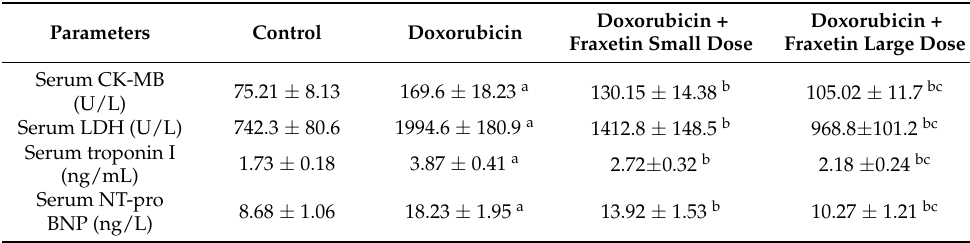
Table 1. Effect of different doses of fraxetin on cardiac function tests in doxorubicin-treated rats (Mean ± SD).